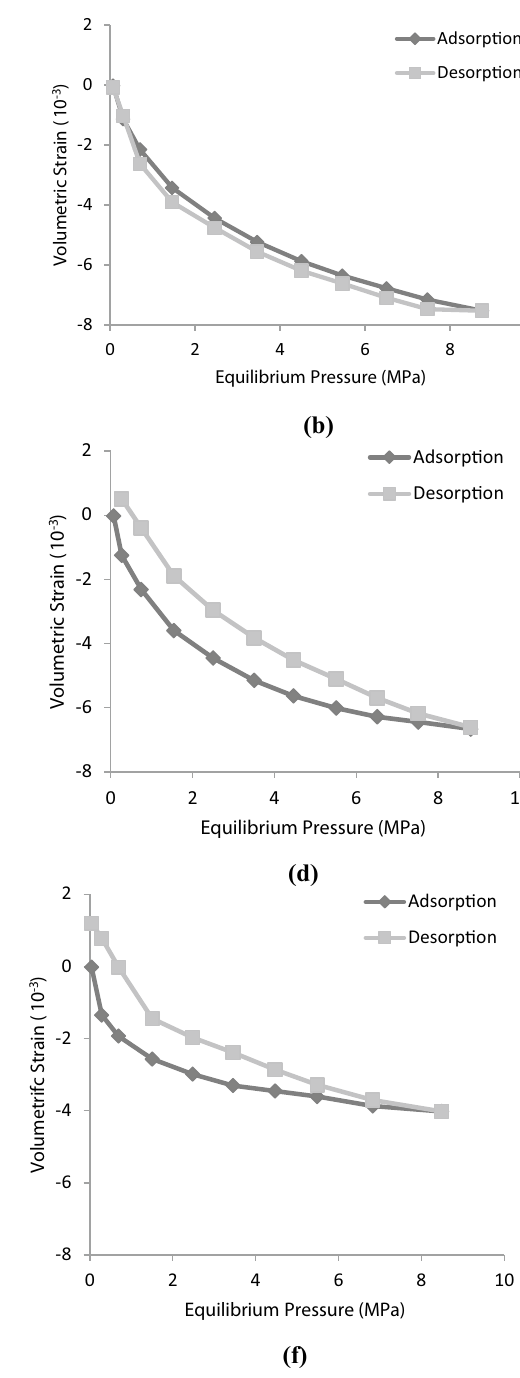
Fig. 2 Observed volumetric stains in different equilibrium pressures of coal particle based on various moisture contents at a 0.00%, b 0.38%, c 0.75%, d 1.42%, e 2.66%, f